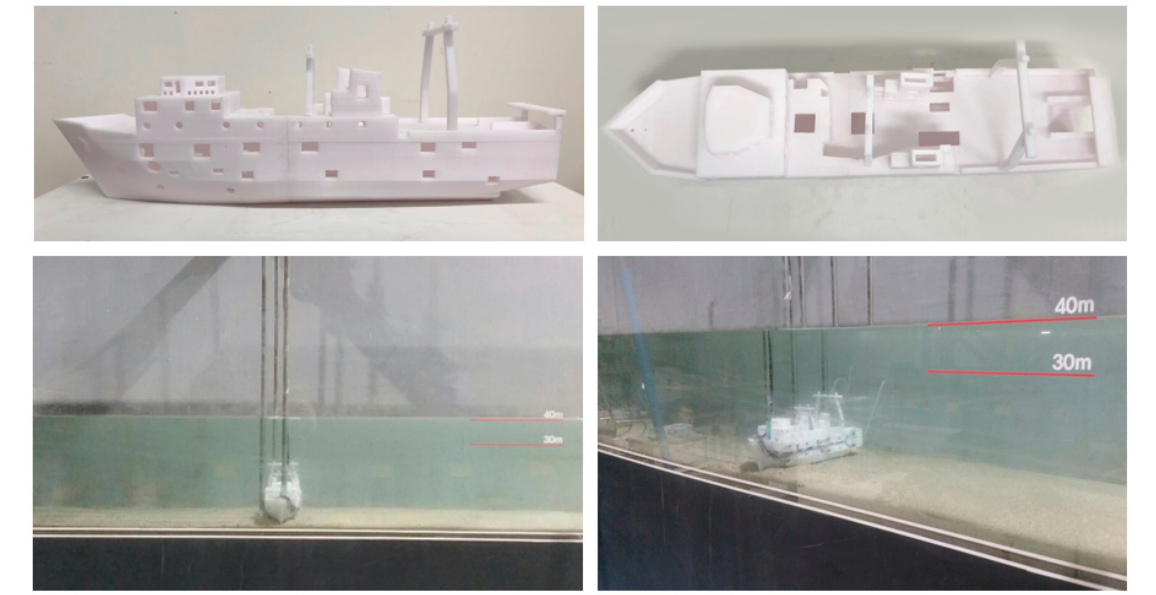
Figure 4. Sunken vessel model produced by 3D printer.